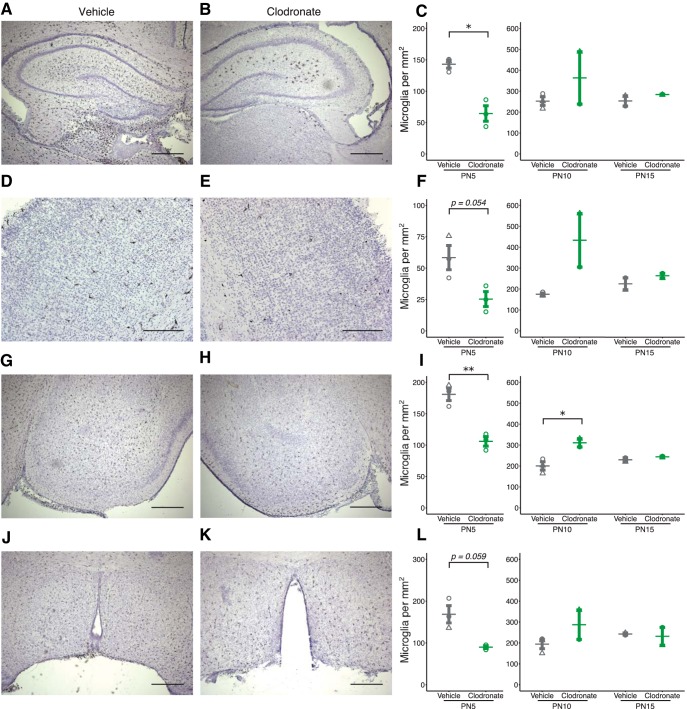
Microglia numbers are reduced after clodronate treatment and rapidly repopulate. Coronal sections of brains from PN5 VEH-treated (a, d, g, j) and LC-treated (b, e, h, k) rats. Representative images from sections labeled for Iba1 and counterstained with hematoxylin from the hippocampus (a, b), cortex (d, e), amygdala (g, h), and hypothalamus (j, k). Quantification of Iba1+ cell density in the hippocampus (c), cortex (f), amygdala (i), and hypothalamus (l) at PN5, 10, and 15. Scale bars = 500 μm (a, b, g, h, j, k) or 250 μm (d, e). Bars indicate group means ± SEM for VEH-treated (black) and LC-treated (green) rats of both sexes. Open circles indicate data from individual female rats, and triangles, from male rats. *p < 0.05, **p < 0.01. n = 2–3 per treatment.